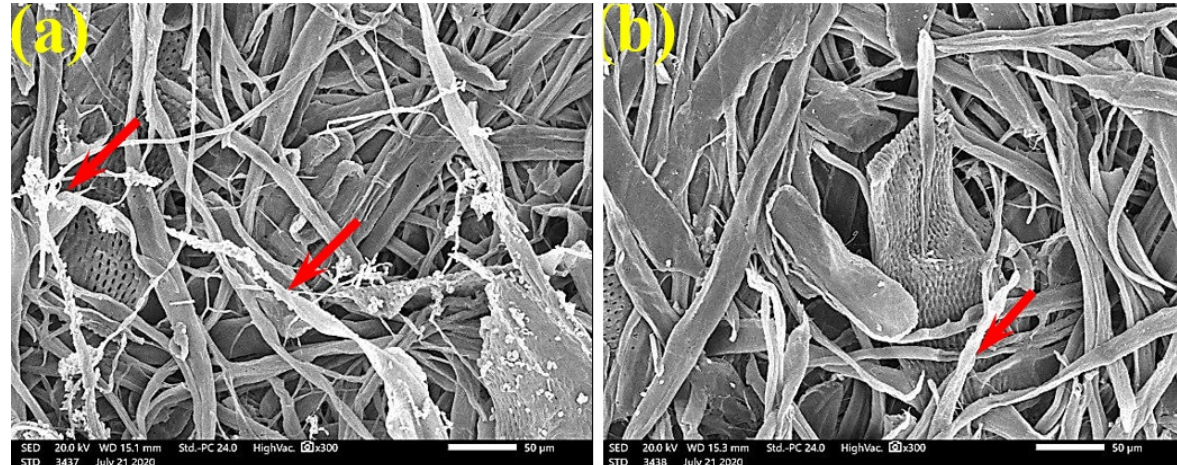
Figure 11. SEM images of paper sheets manufactured from ( a ) B. speclabilis and ( b ) F. altissima treated with 0.5% MAHE and inoculated with S. solani . Arrows refer to low and no growth of fungal mycelia based on the concentration of the extract and the type of paper sheet pulp.